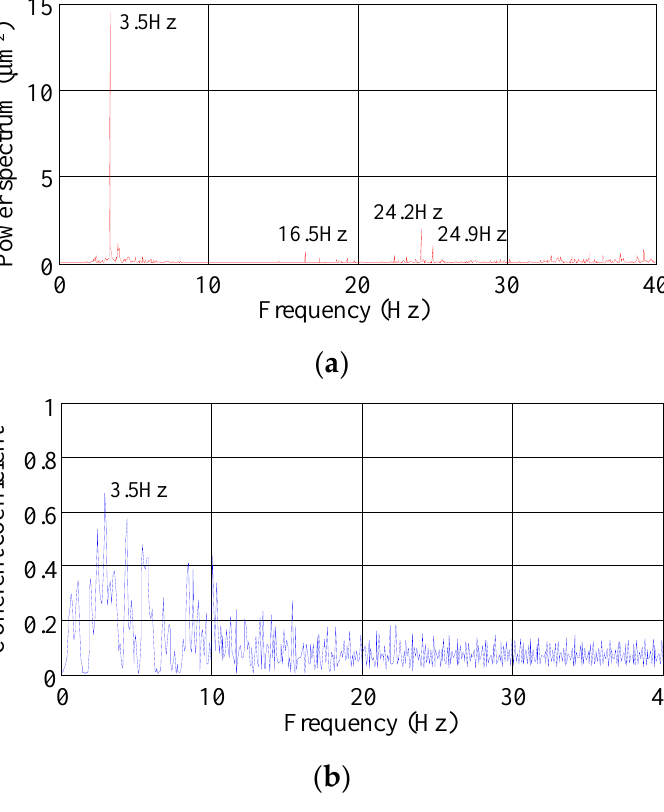
Figure 15. MP-FRF ( a ) and coherence coefficient ( b ) between the signal at orifice and T9.